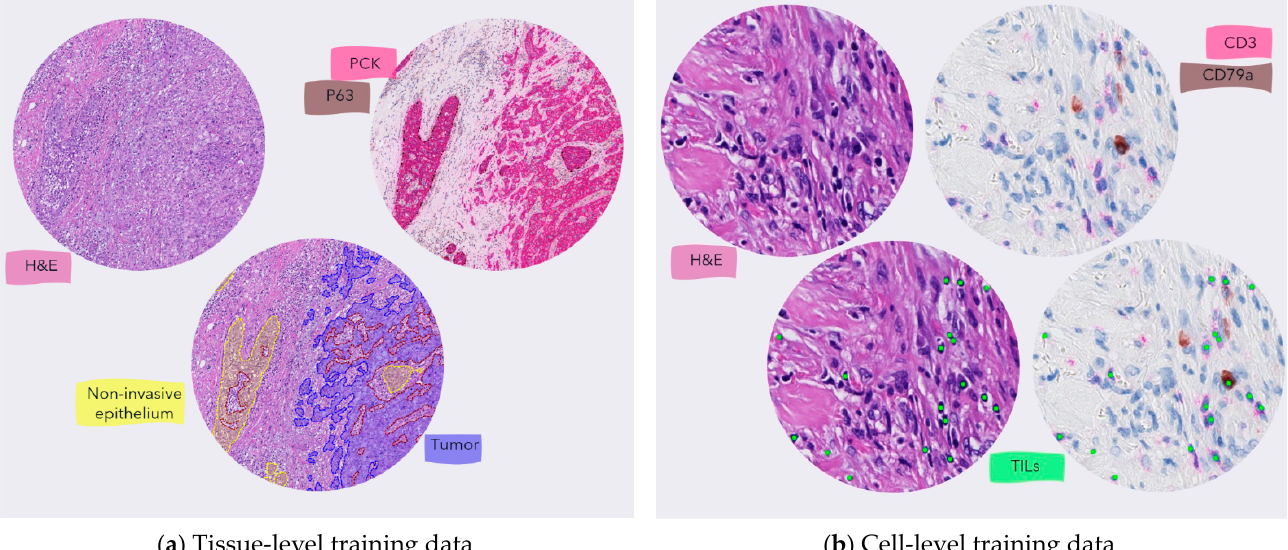
Figure 2. The process to generate objective training data. ( a ) The training annotations for the tissue-level model were generated using IHC when available. For the images from the TCGA-BRCA, the annotations were manually generated by a pathologist. ( b ) the TILs training annotations were generated as center-dot labels on cells that were either CD3 or CD79a positive to make sure that all mononuclear immune cells were included as stated by the TIL-WG guideline.